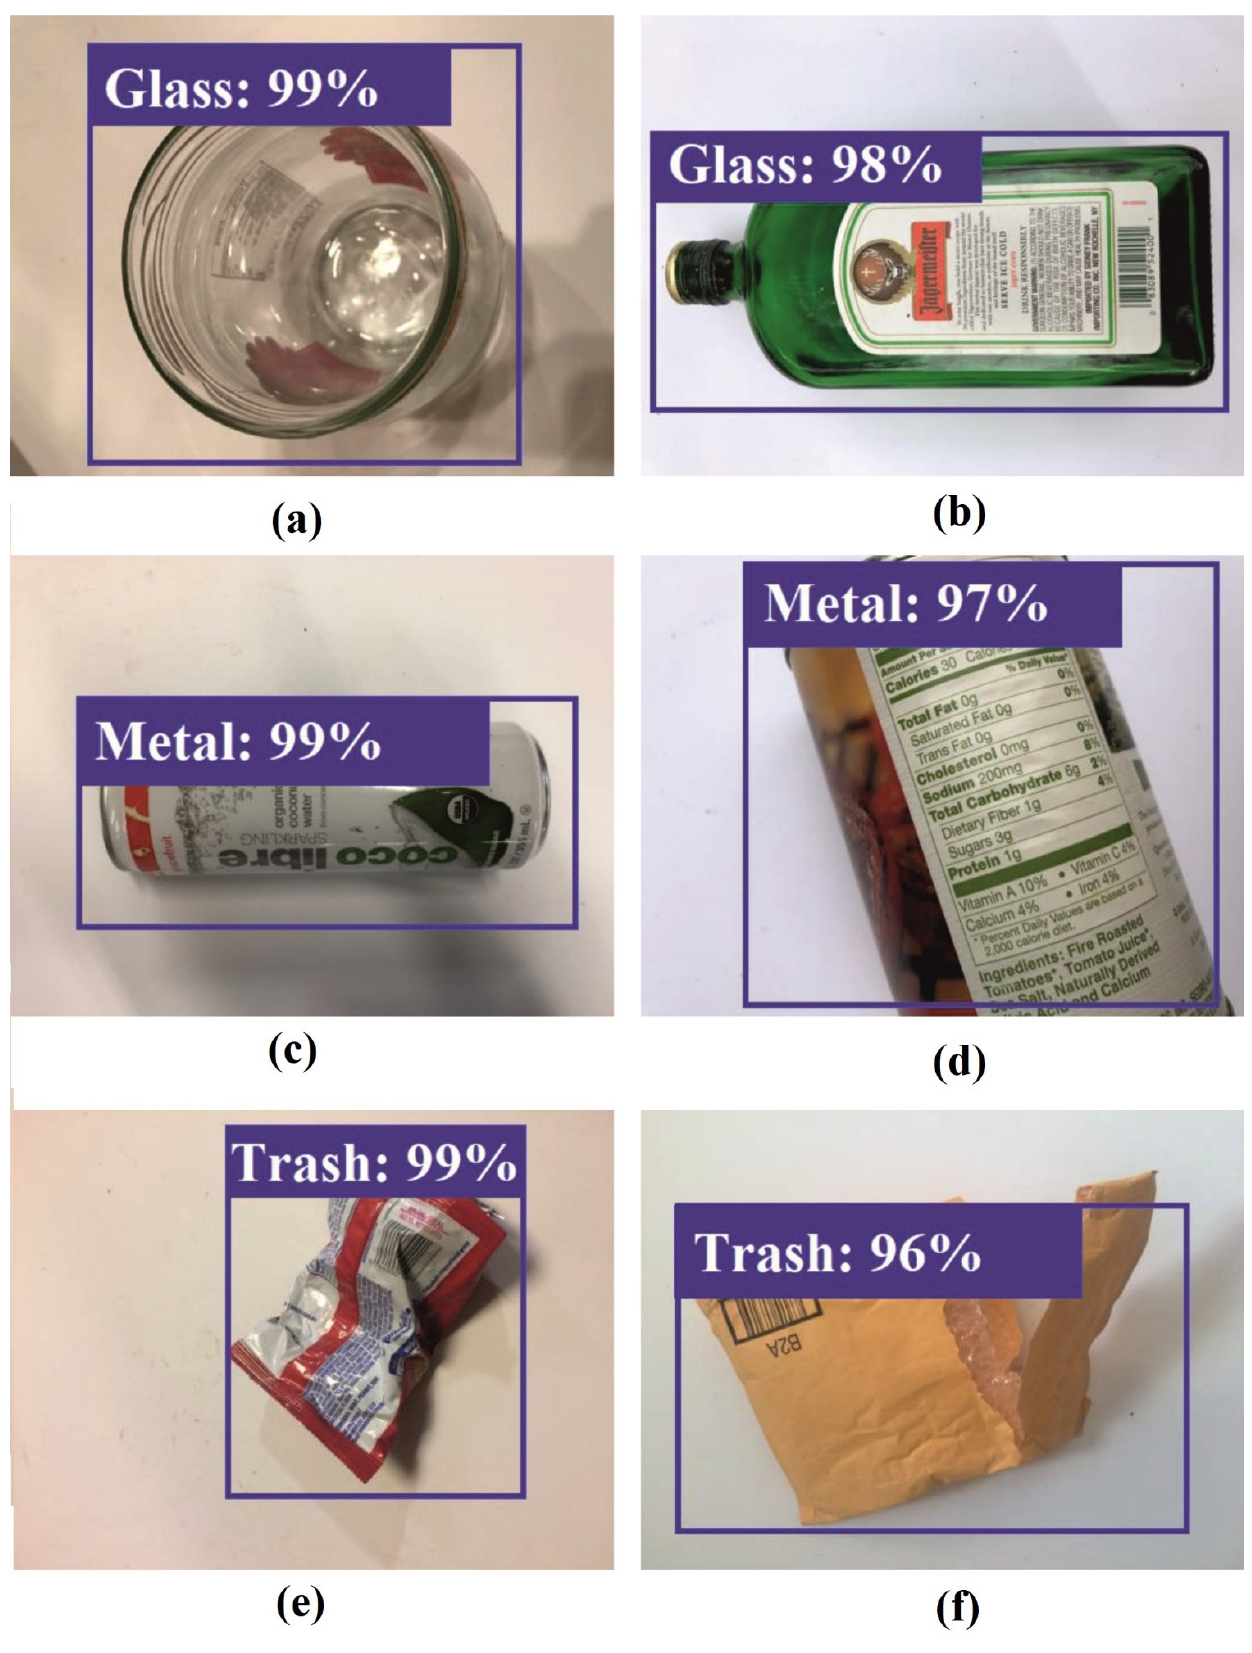
Figure 4. Visualization of sample object detection. ( a , b ) Glass, ( c , d ) metal, and ( e , f ) trash.